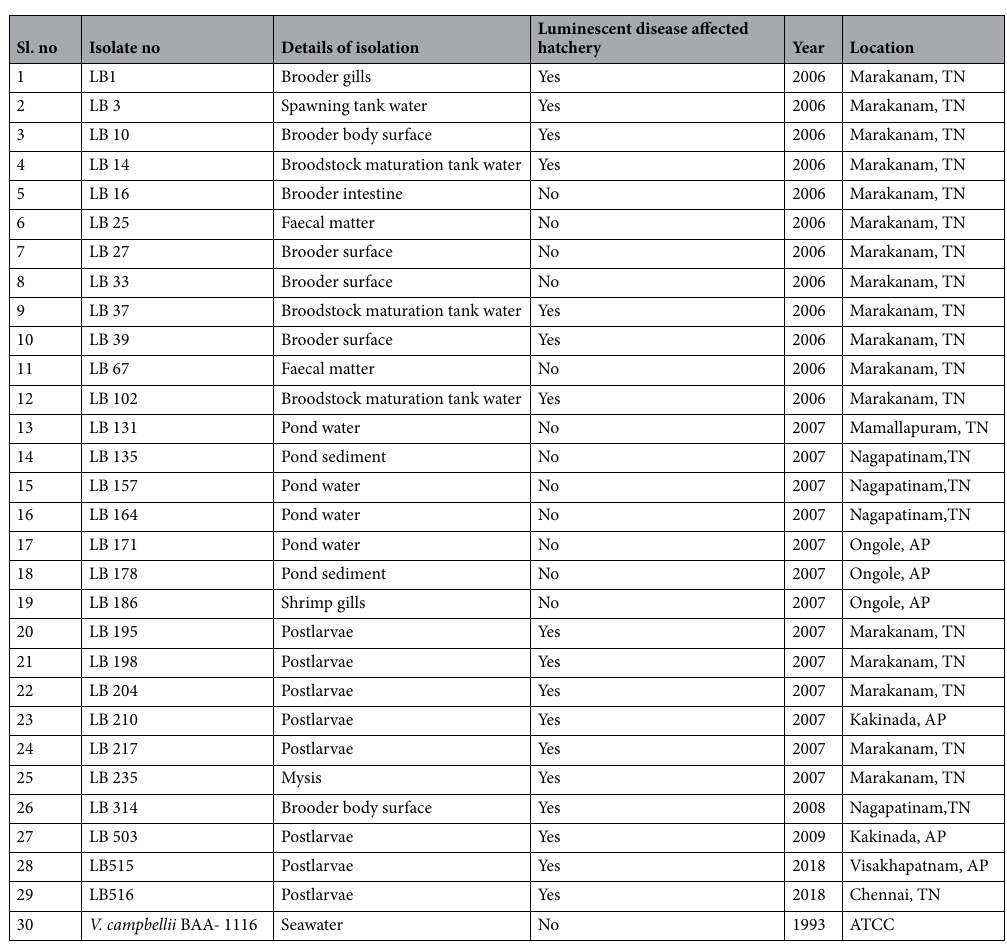
Table 1. Vibrio isolates used for the study. AP Andhra Pradesh; TN Tamil Nadu; ATCC American Type Culture